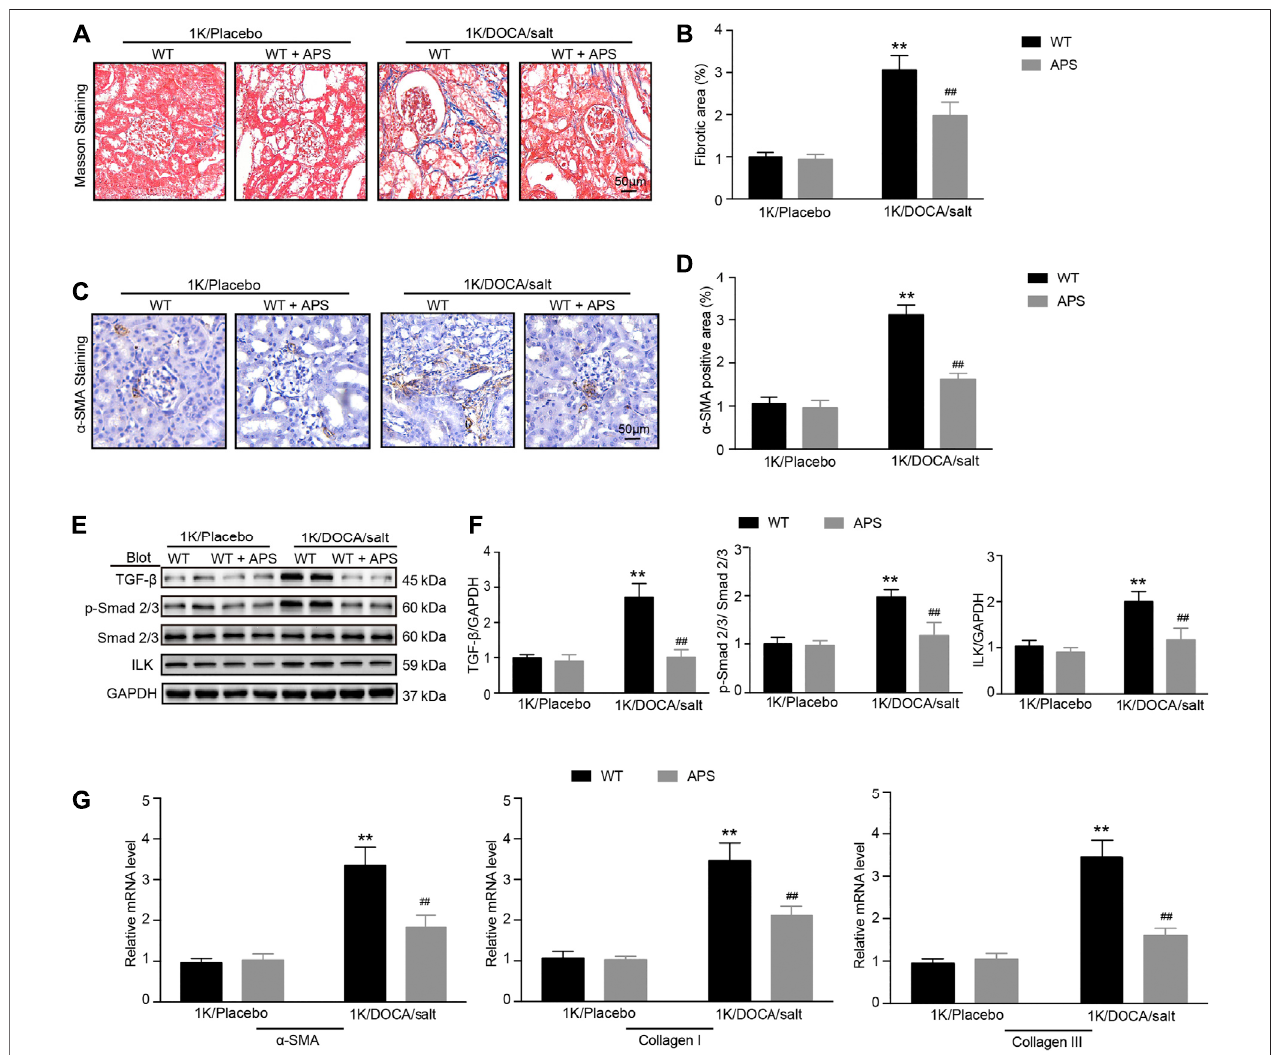
FIGURE 3 | APS prevents collagen deposition in DOCA-treated mice. (A) Masson staining of each group was analyzed (scale bar 50 μ m). (B) Percentage of the fi brotic area was analyzed ( n (cid:1) 6 per group). (C) Immunochemistry staining of the kidney sections with α -SMA (scale bar 50 μ m). (D) Quanti fi cation of α -SMA-positive area ( n (cid:1) 6). (E) Immunoblotting analysis of TGF- β 1, phospho-Smad2/3, Smad2/3, and ILK protein in each group ( n (cid:1) 4 per group). (F) Quanti fi cation of protein bands ( n (cid:1) 4). (G) qPCR analysis of α -SMA, collagen I, and collagen III mRNA expression levels in the kidney ( n (cid:1) 6). ** P < 0.01 versus control mice. ## P < 0.01 versus DOCA + APS mice.